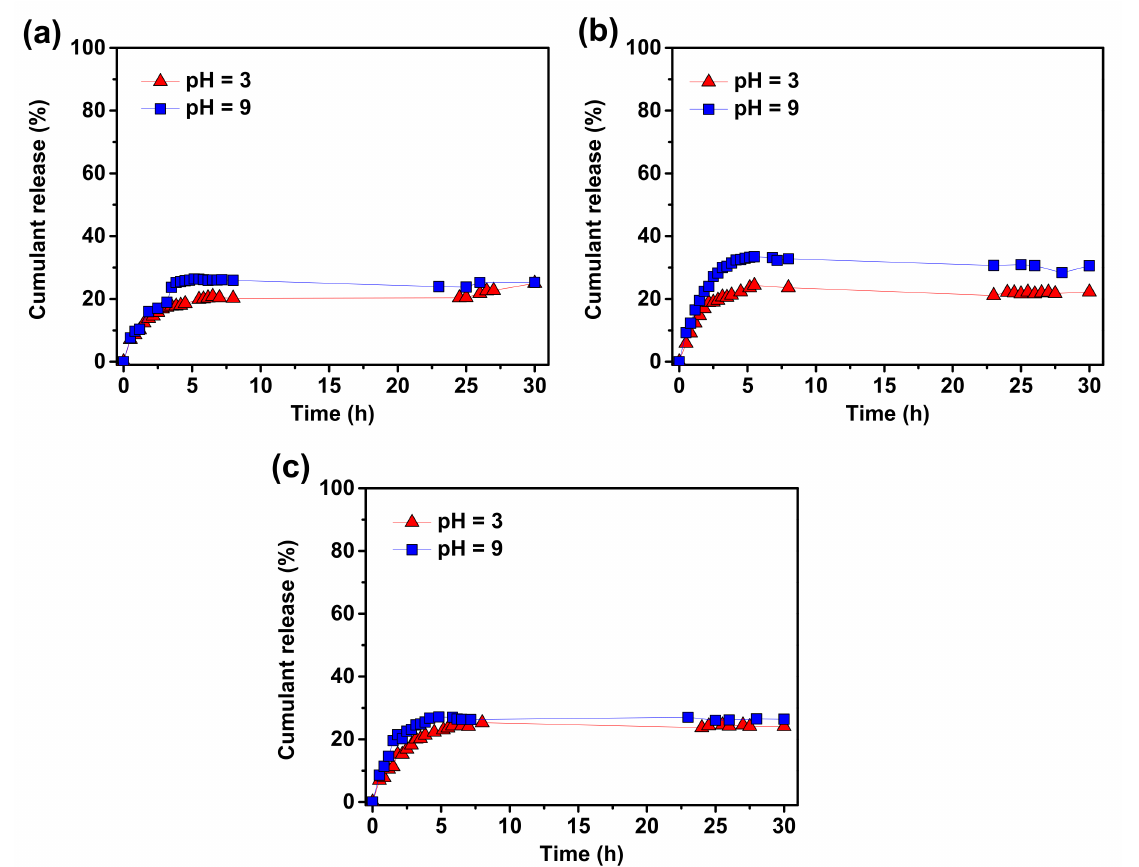
Figure 6. In vitro release profile of quercetin from QC-loaded monomolecular micelles composed of macromolecules with ( a ) 40, ( b ) 67, and ( c ) 157 AA mers in side chains incubated in aqueous solutions at 37 ◦ C. The measurements conducted for the final products from the syntheses shown in Table 1, entry